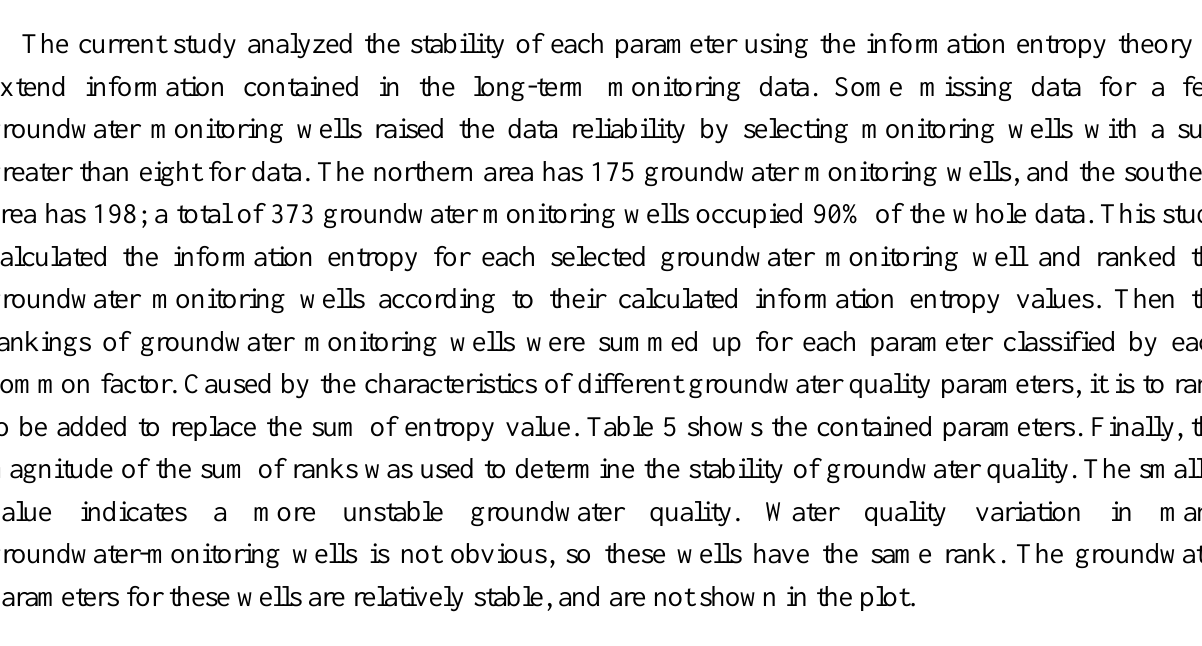
Table 5. Statistics on the ranks of information entropy values for common